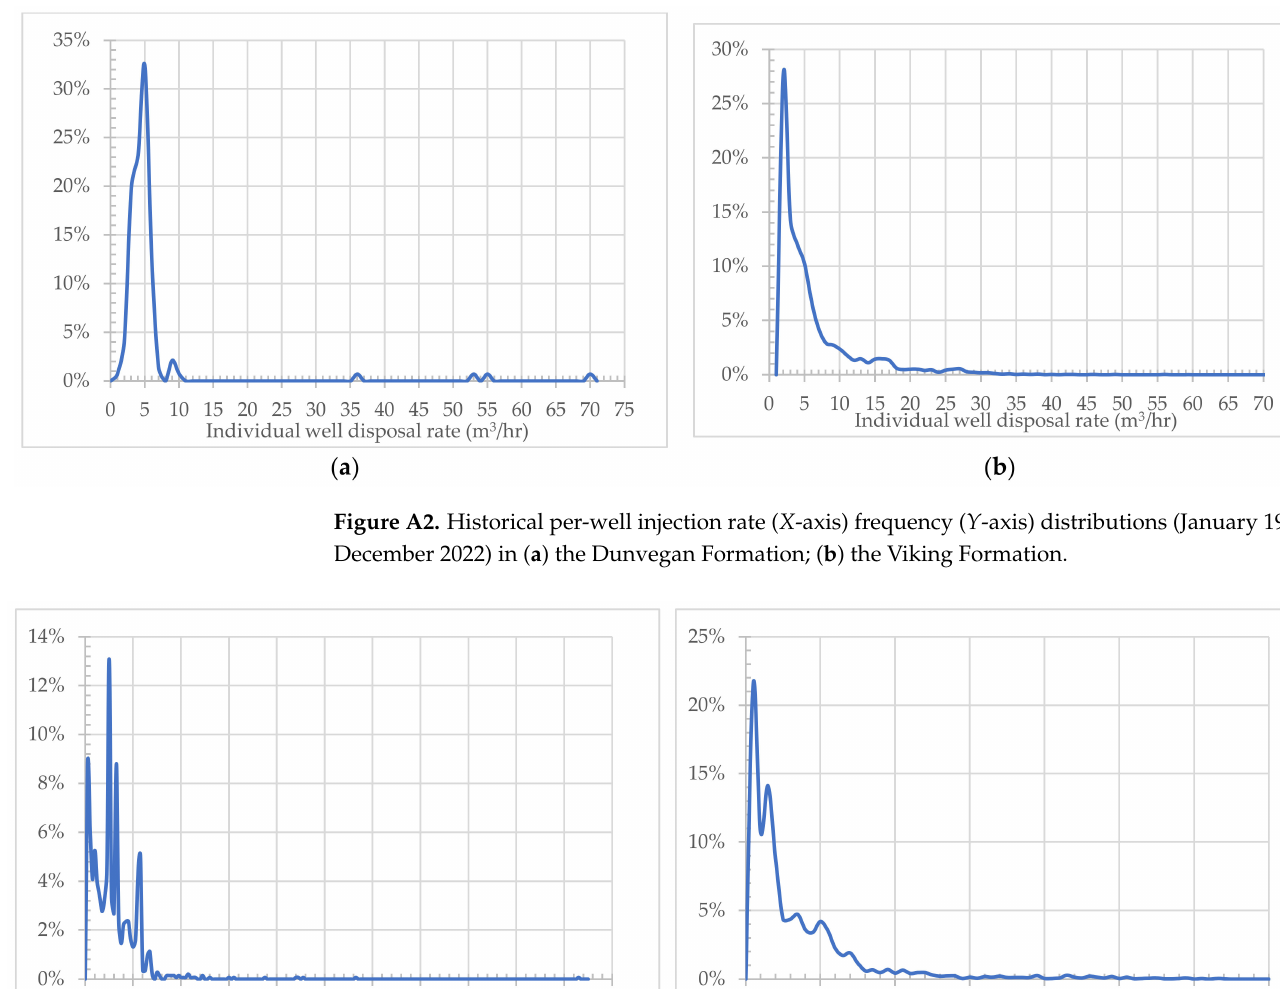
Figure A1. Historical per-well water injection rate ( X -axis) frequency ( Y -axis) distributions (January 1962–December 2022) in ( a ) the Belly River Formation; ( b ) the Cardium Formation.